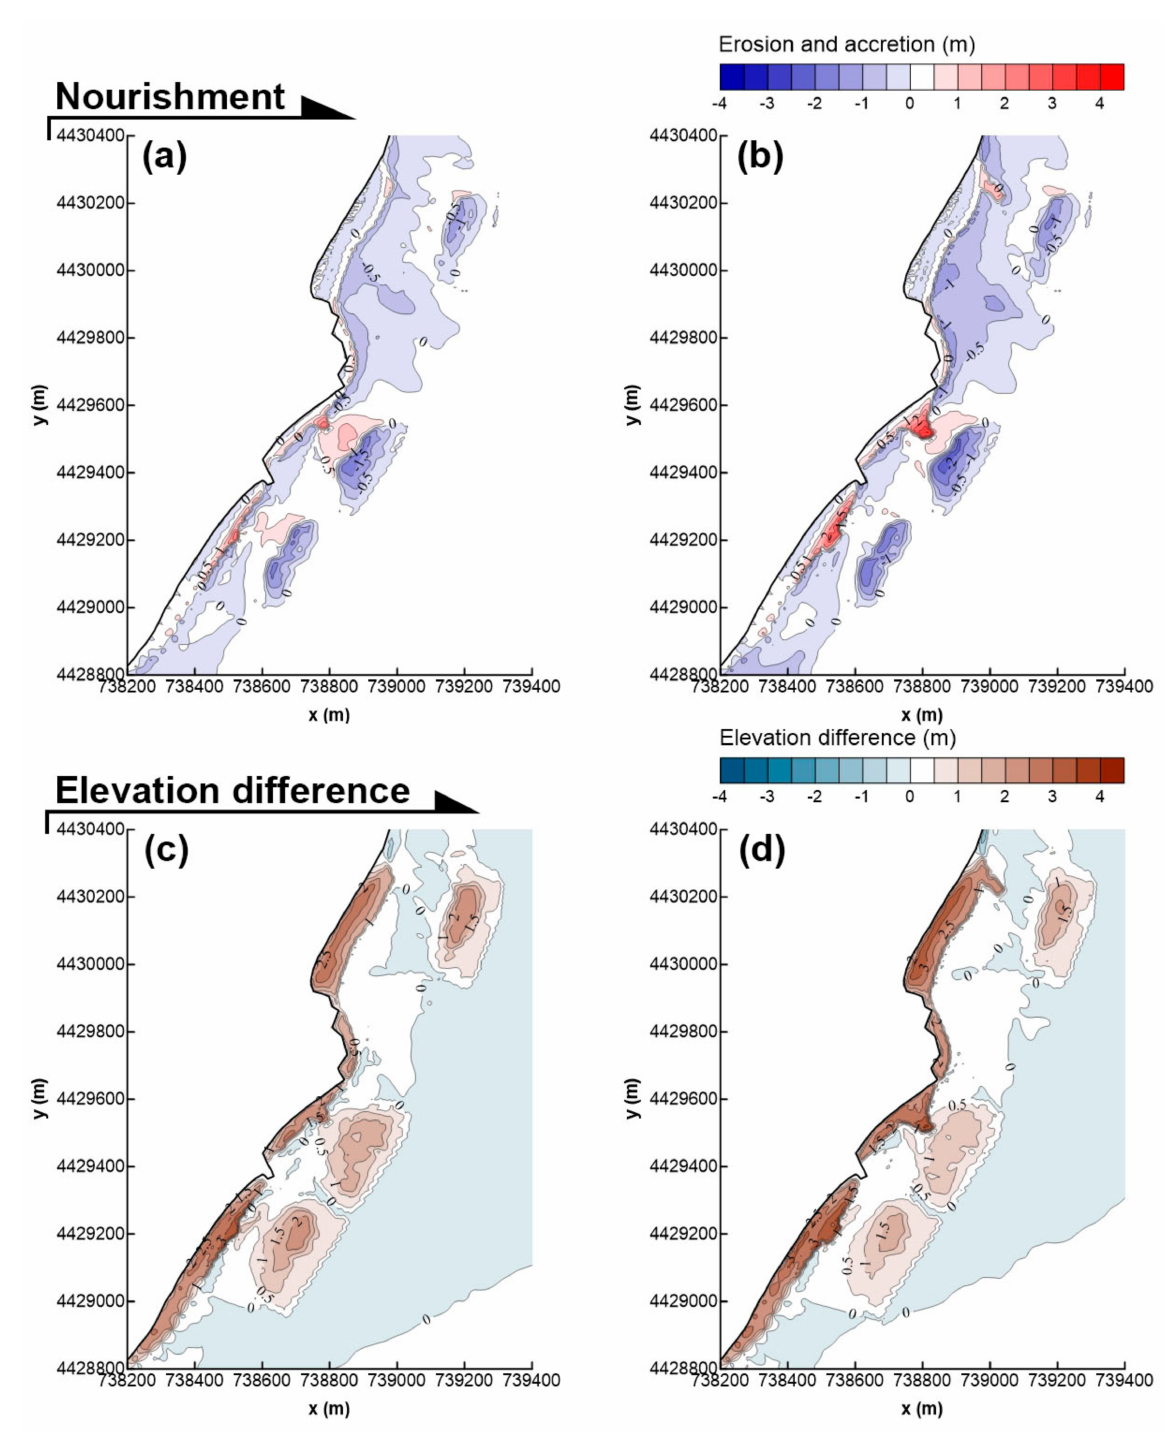
Figure 14. ( a , b ) Morphological changes in scenario with beach nourishment and ( c , d ) the elevation difference between scenarios with and without the beach nourishment in 2 (left panel) and 5 years (right panel) after the beach